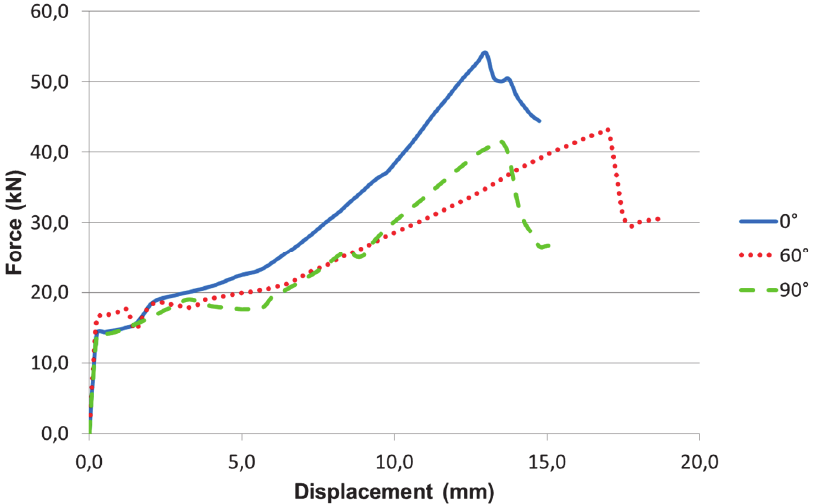
Figure 4: Comparison of the test records of round timber samples loaded in tension at different